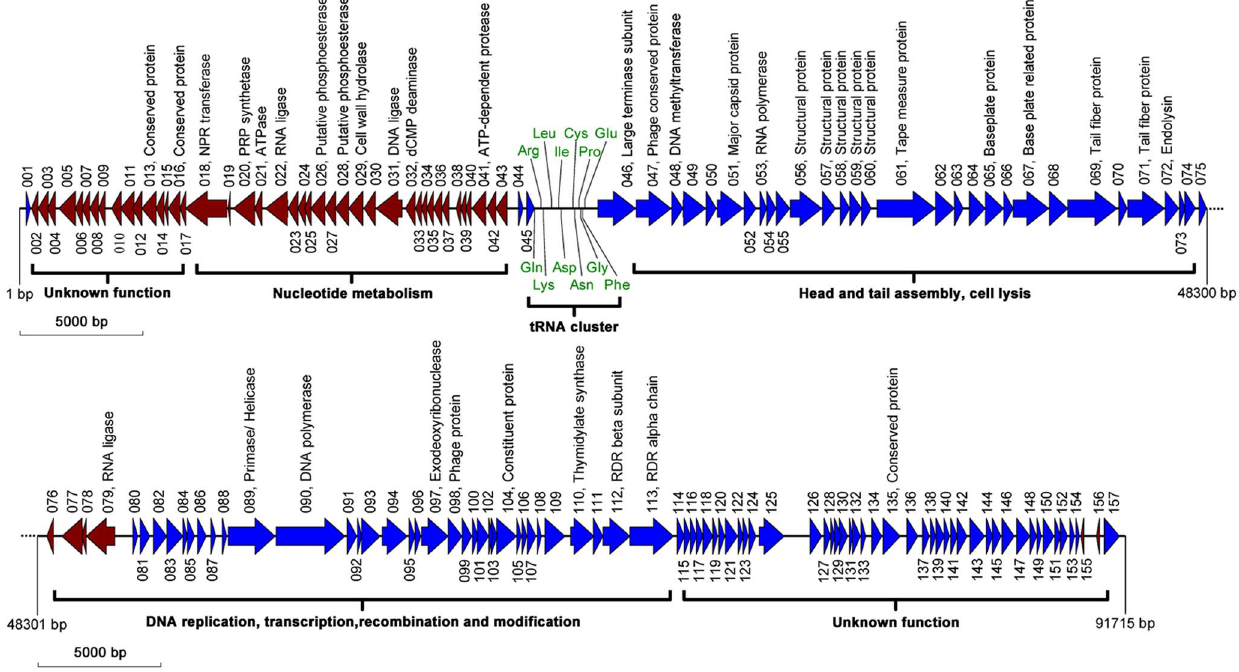
Figure 6. Diagram of the PaP1 genome with functional annotations. Blue arrowheads show genes on the plus strand; brownish red arrowheads show genes on the minus strand; green words refer to the amino acid transferred by the corresponding tRNA. NPR: nicotinamide phosphoribosyl, PRP: phosphoribosylpyrophosphate, RDR: ribonucleotide diphosphate reductase. doi:10.1371/journal.pone.0062933.g006 PLOS ONE |